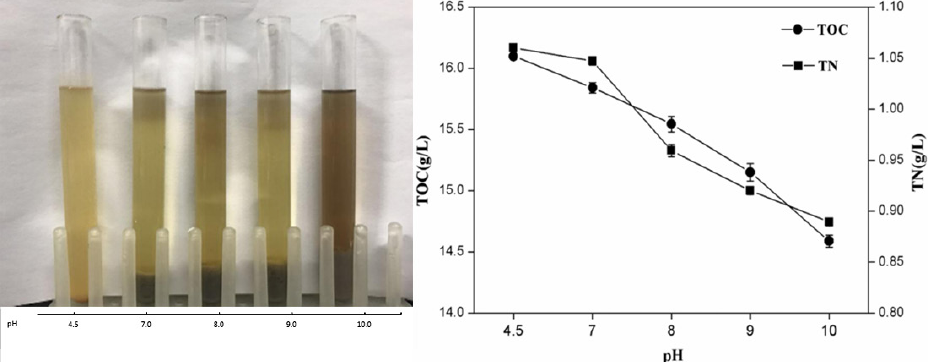
Fig. 1. Removals of TOC and TN from landfill leachate by increasing